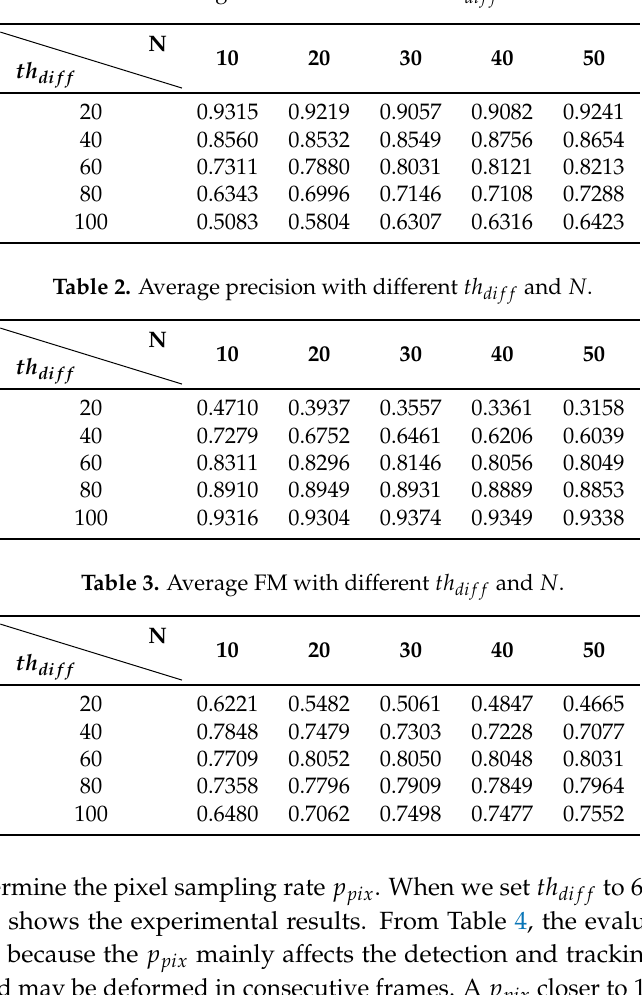
Table 1. Average recall with different th dif f and N .